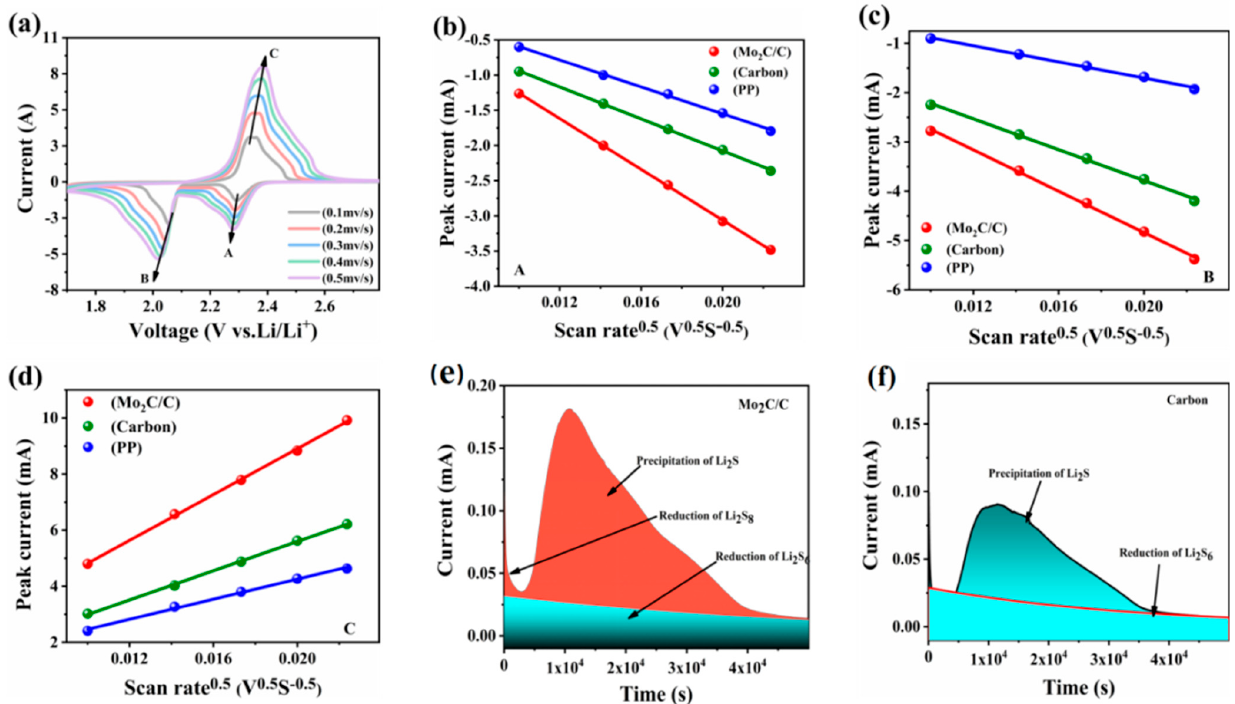
Figure 4. ( a ) CV curves of the battery with a Mo 2 C/C-modified separator at scan rates ranging from 0.1 to 0.5 mV s − 1 . ( b – d ) Relationship between CV peak currents and scan rates for LSBs using different separators. ( e , f ) Chronoamperometry results of constant current and constant voltage discharge at 2.05 V on Mo 2 C/C and a carbon nanosheet.